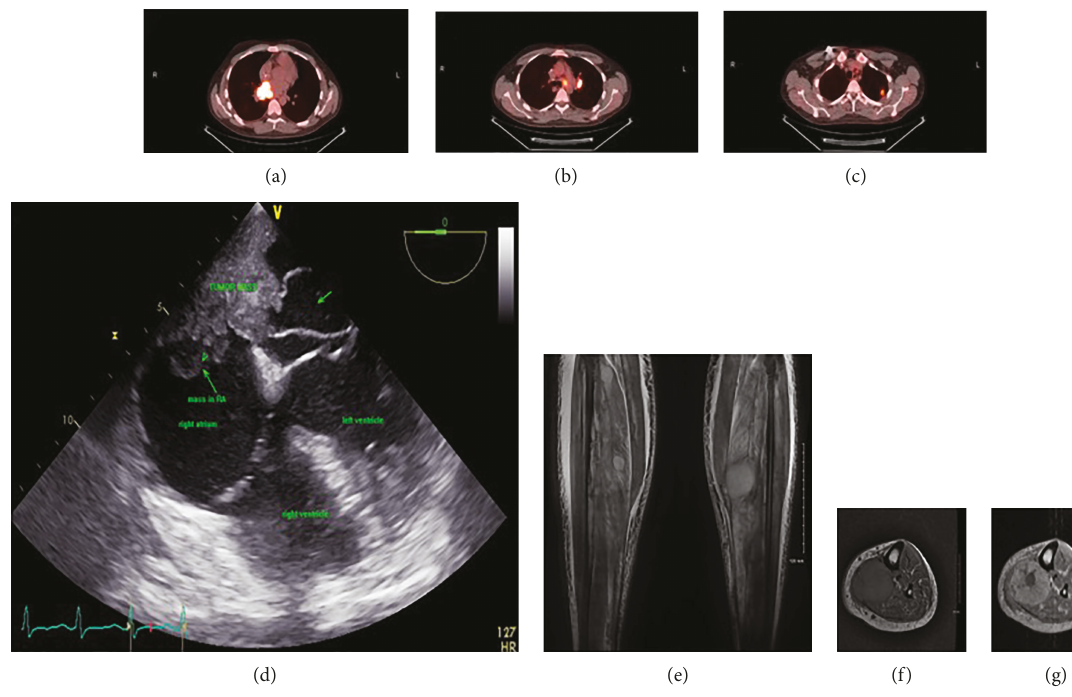
Figure 1: (a – c) PET scan images demonstrate increased uptake within nodes in the aortic pulmonary window, left hilum, and a mass in the left upper lung. (d) Transesophageal echocardiography shows large cardiac mass invaded to the intra-atrial septum and right and left atrium with cystic lesion protruding to the left atrium. (e – g) MRI with and without contrast shows multiple enhancing neoplastic masses in the muscle compartment in both lower extremities which are believed to be due to metastatic